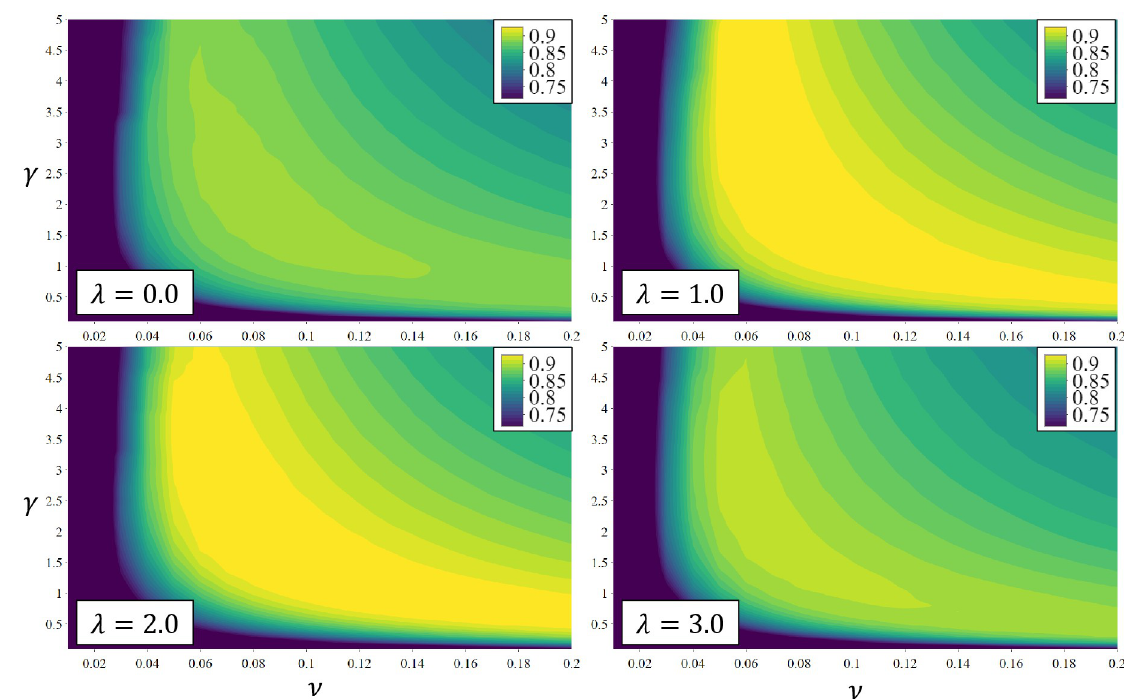
Fig 8. ACC as a function of γ and ν for a value of τ = − 0.1. A similar rate is represented as the same color with the maximum 1% difference, with the highest rates as yellow.